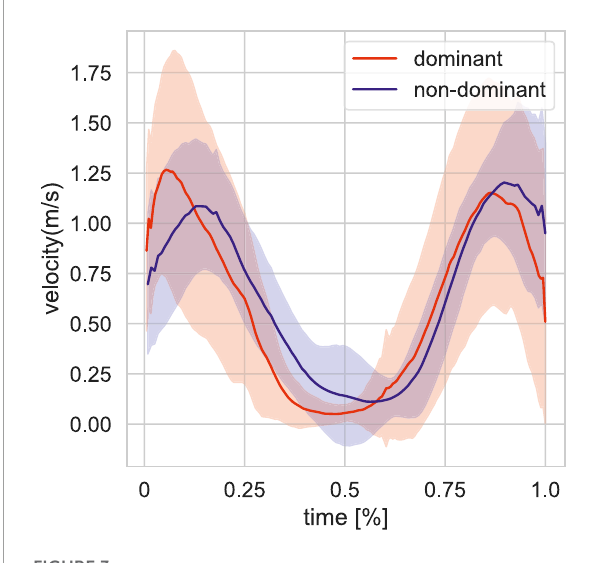
FIGURE 3 Averaged hand velocity profile for front targets in training set for the dominant and non-dominant